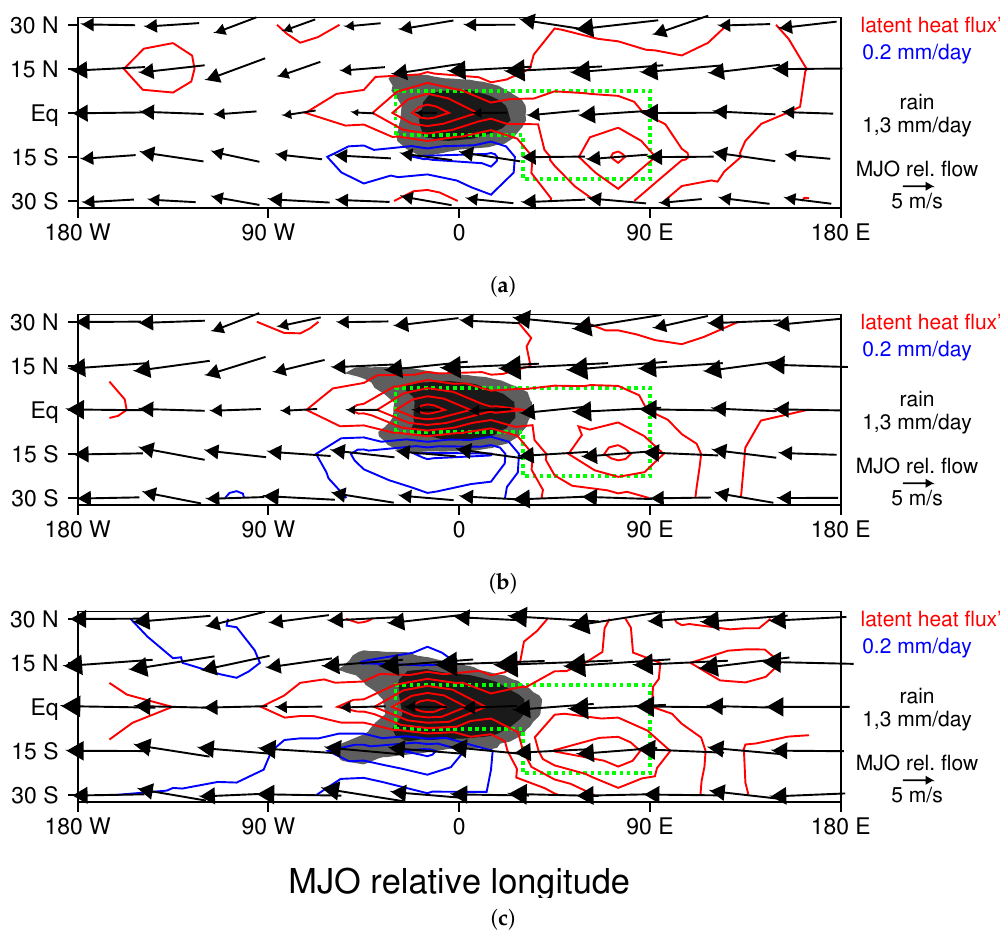
Figure 9. Change in evaporation due to MJO wind perturbations (0.2 mm/day contour interval, with red (blue) contours denoting positive (negative) values): ( a ) control simulation; ( b ) 3 K warming experiment; and ( c ) 7 K warming run. Regions where perturbation rainfall exceeds 1 (3) mm/day are shaded light (dark) gray. Vectors indicate the mean low-level flow (700–1000 hPa) relative to the motion of the MJO’s precipitation center (i.e., they show how a low-level parcel would move in the MJO’s frame of reference). The average surface evaporation for the region outlined with a dotted green line, as well as it change due to ocean warming, is quantified in Figure